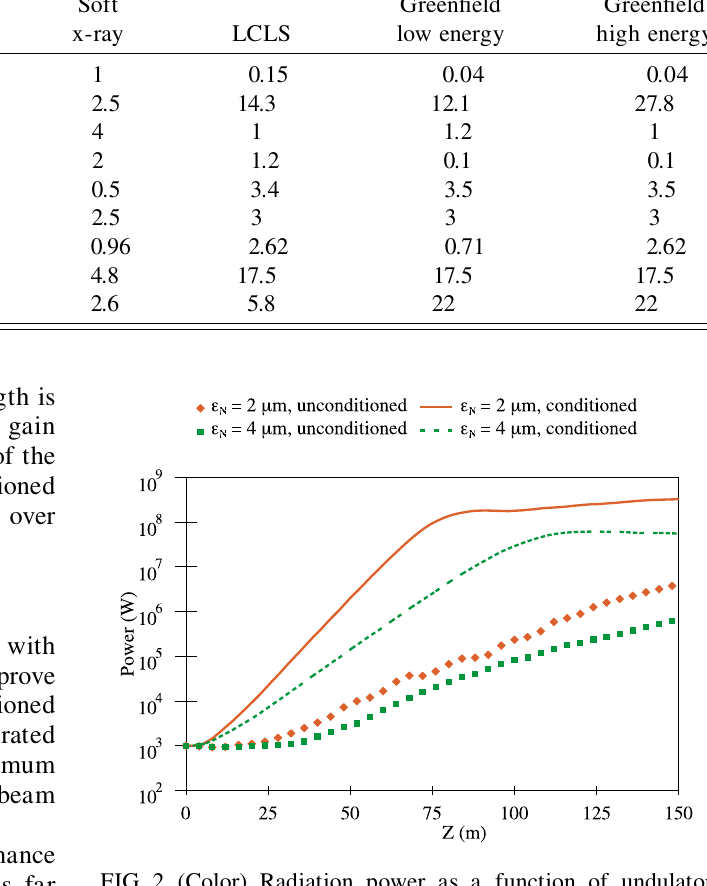
FIG. 2. (Color) Radiation power as a function of undulator length in the soft x-ray FEL. Conditioned and unconditioned beams at different emittances are compared.